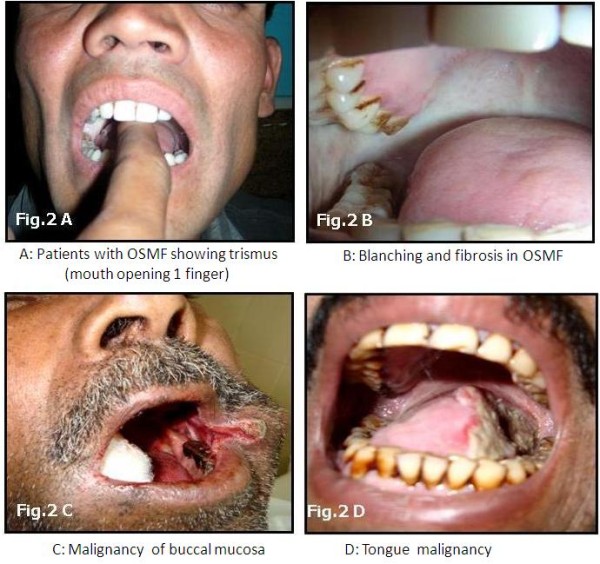
Clinical picture of patients with OSMF and HNSCC.